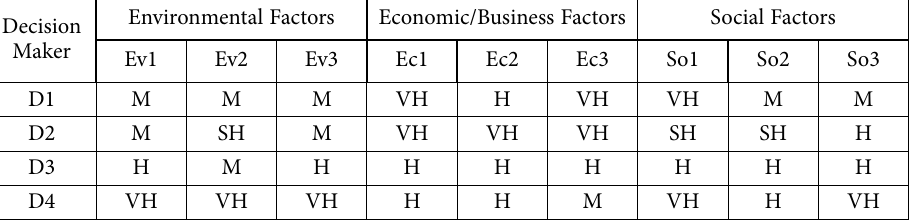
Table 2. Grey scale variable matrix for initial evaluations of sustainability factor importance by each decision maker Decision Maker